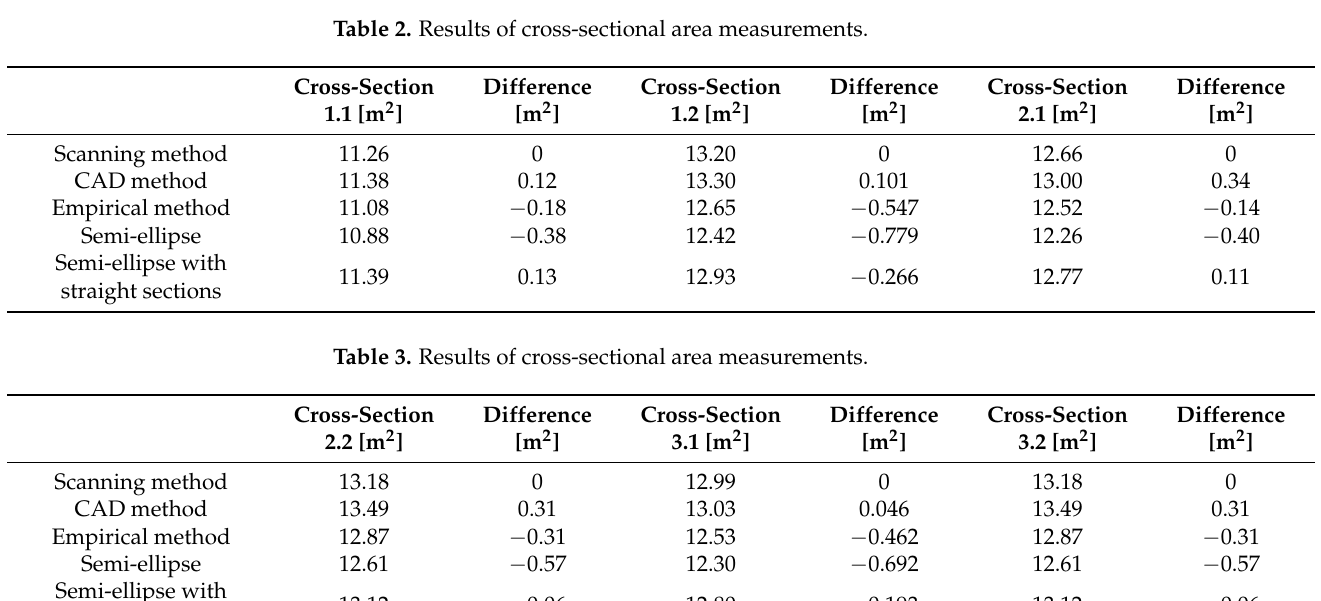
Table 3. Results of cross-sectional area measurements.